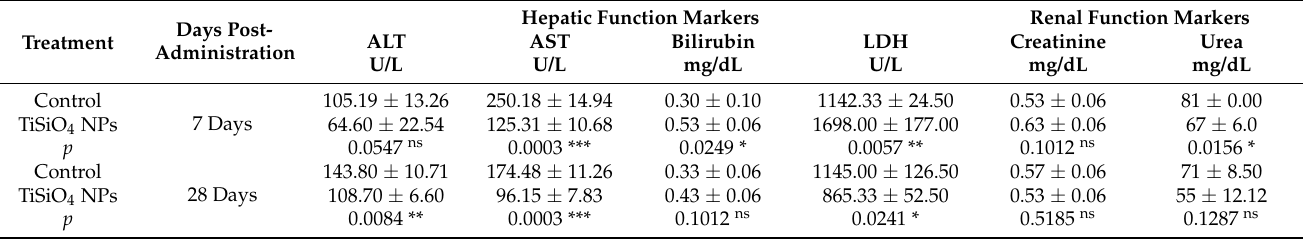
Table 3. Hepatic and renal toxicity in male rats exposed orally to 250 mg ≤ 50 nm TiSiO 4 NPs/kg